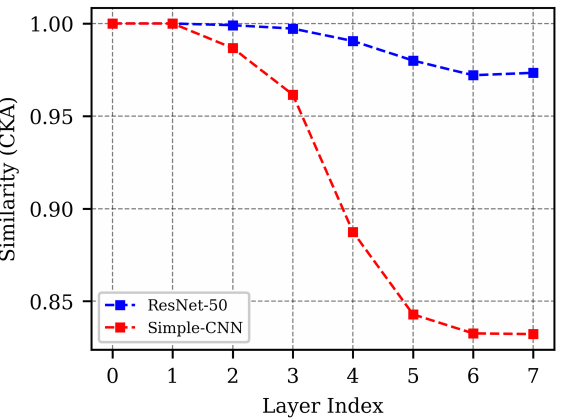
Figure 2. CKA similarity between clients at the end of training (refer to Experimental Setup for more information on